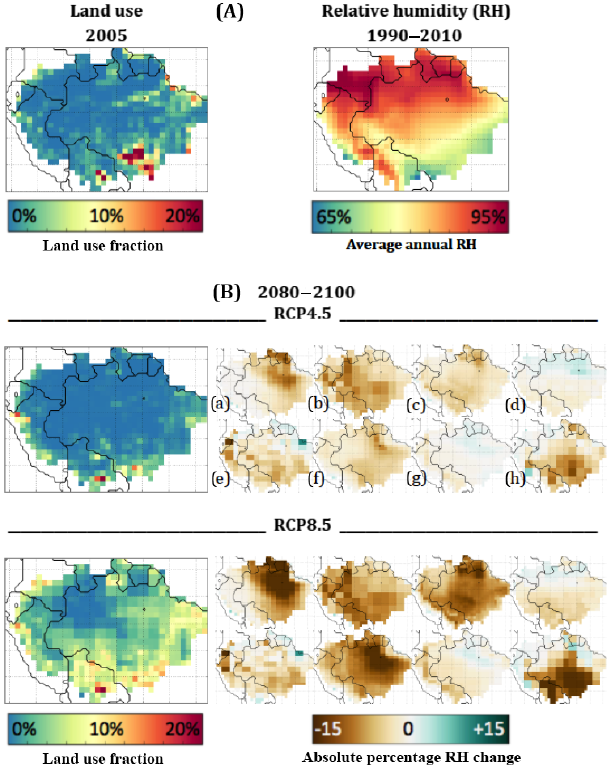
Figure 1. Current and projected climate and land use in the Ama- zon basin. (A) Land use fraction in 2005 (croplands + urban lands) from MODIS (Friedl et al., 2010) and average annual relative hu- midity over 1990–2005 from NCEP (Kanamitsu et al., 2002). (B) Land use fraction in 2080–2100 in the RCP4.5 and RCP8.5 sce- narios (Hurtt et al., 2011) and change in average relative humid- ity from eight of the IPCC AR5 climate models: (a) ACCESS1- 3; (b) 3CanESM2; (c) GFDL-ESM2M; (d) IPSL-CM5A-MR; (e) HadGEM2-CC; (f) MIROC-ESM; (g) GISS-E2-H; (h) CESM1-